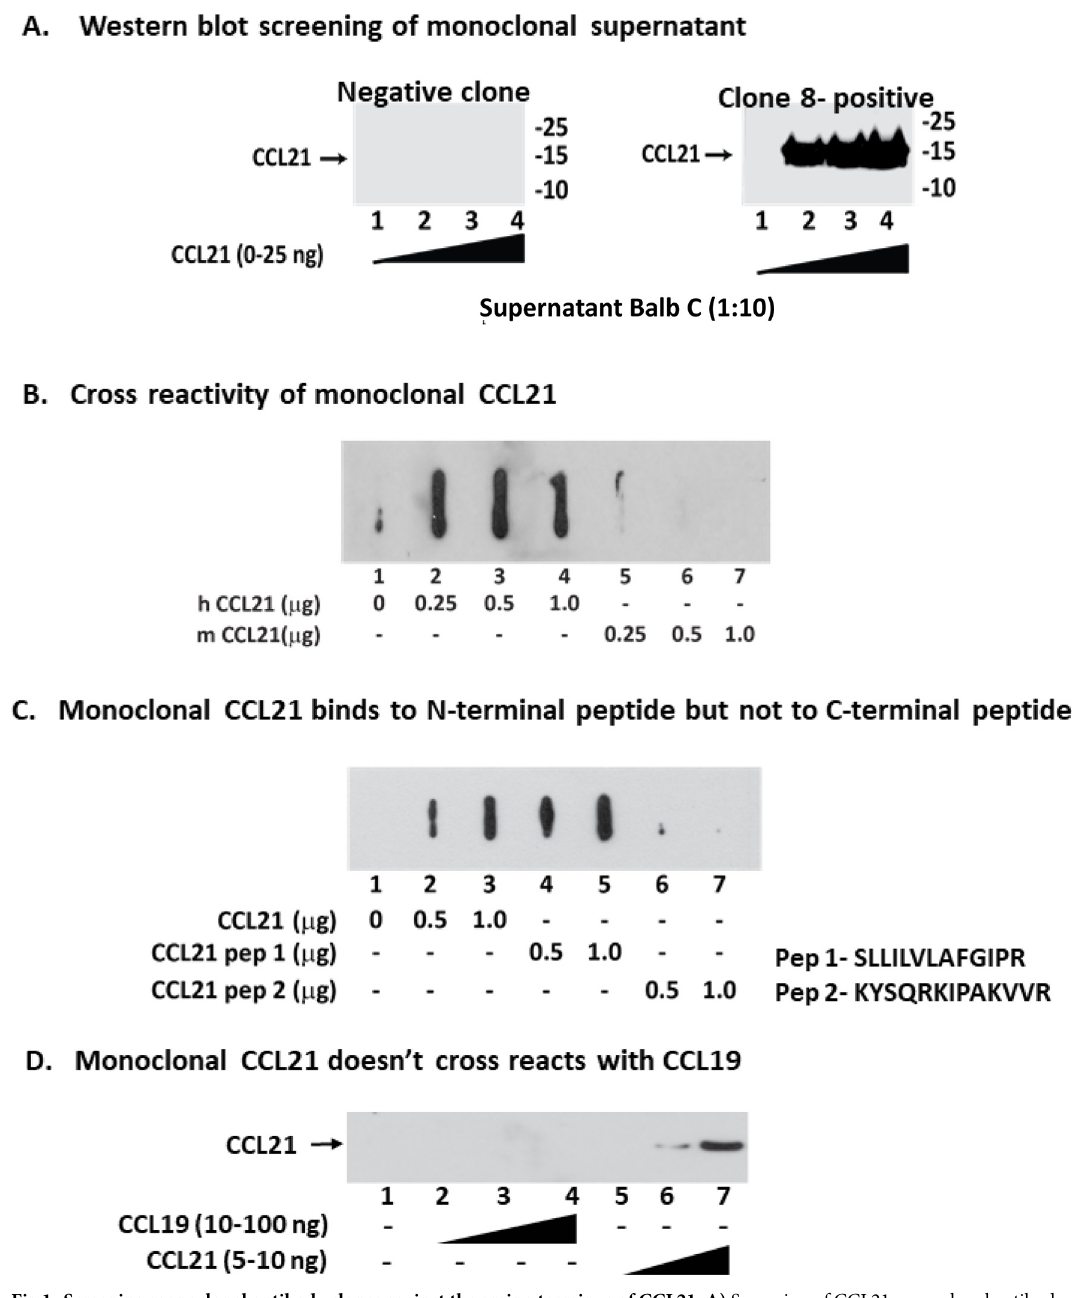
Fig 1. Screening monoclonal antibody clones against the amino terminus of CCL21. A) Screening of CCL21 monoclonal antibody clones by western blotting for binding to the human CCL21 protein as a single band. Clone #8 (C8) results are shown for all assays in this figure. B) Cross reactivity of monoclonal anti-CCL21 antibody to human and mouse CCL21 protein. We then screened the clones for lack of binding to murine CCL21 by slot blot hybridization. C) Screening of a peptide from the CCR7-interacting amino terminal region of CCL21 could compete off the monoclonal from binding CCL21 using slot blot hybridization. D) Screening of monoclonal antibody clones for lack of binding to the related human chemokine CCL19. Thirty-three monoclonal antibodies passed all of these